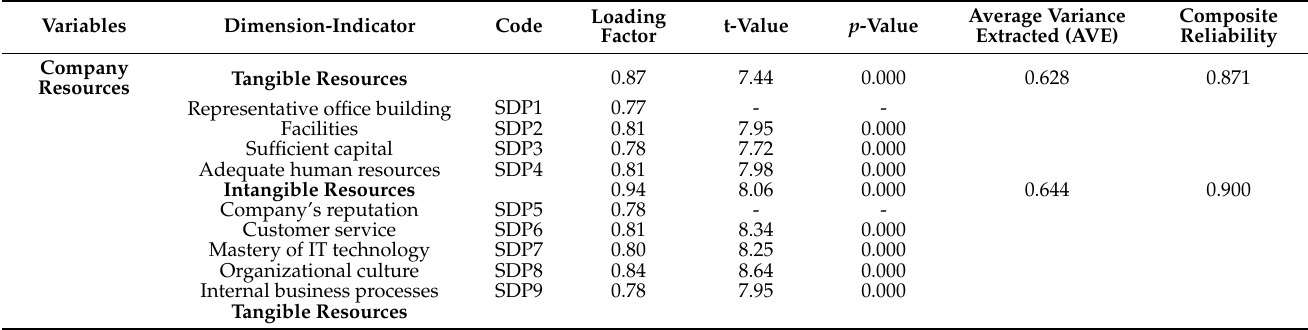
Table 4. Measurement Model Source: Lisrel 8.7